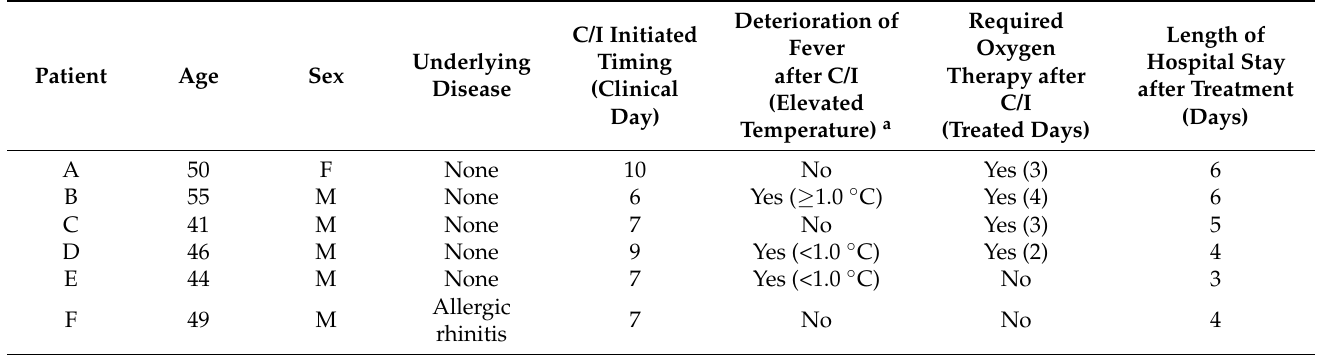
Table 2. Clinical feature of patients treated by casirivimab/imdevimab in the late phase of SARS- CoV-2 infection.